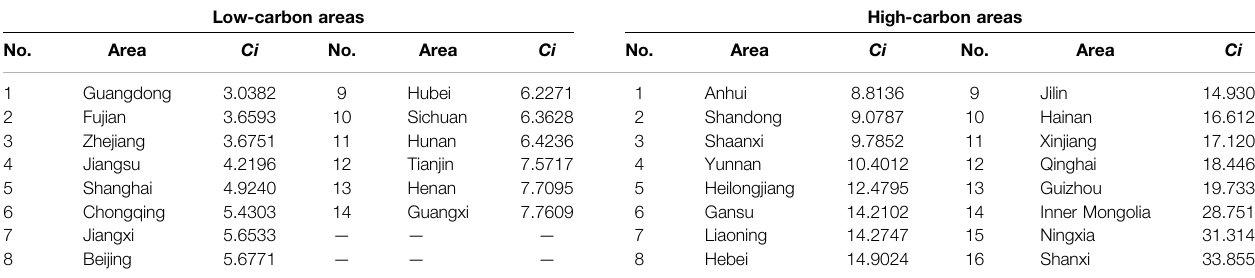
TABLE 1 | Average industrial carbon emission intensity in various provinces in China from 2004 to 2019 (tons/million).